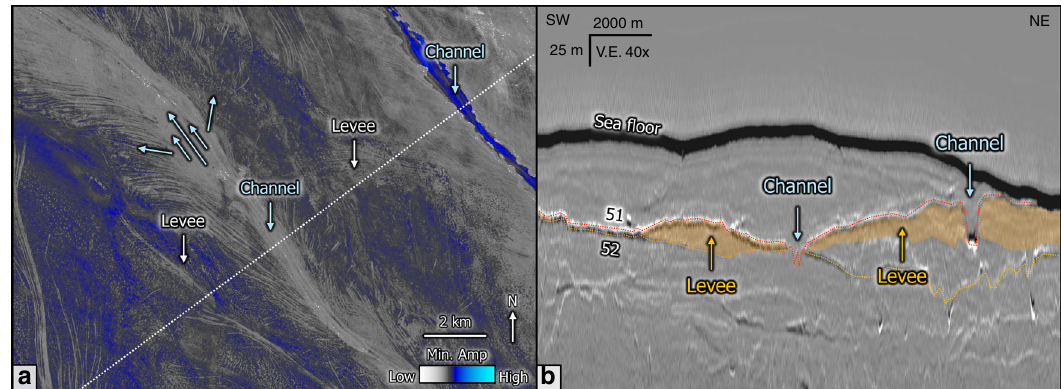
Fig. 5 Seismic geomorphology of the uppermost channel-levee system. a Minimum amplitude extraction of Horizon 51 showing seismic response of channel-levee system. b Seismic pro fi le across channel-levee system highlighting levee geometry and levee facies. Horizon 51 (red line) and Horizon 52 (yellow line) are shown. Seismic data courtesy of TGS.